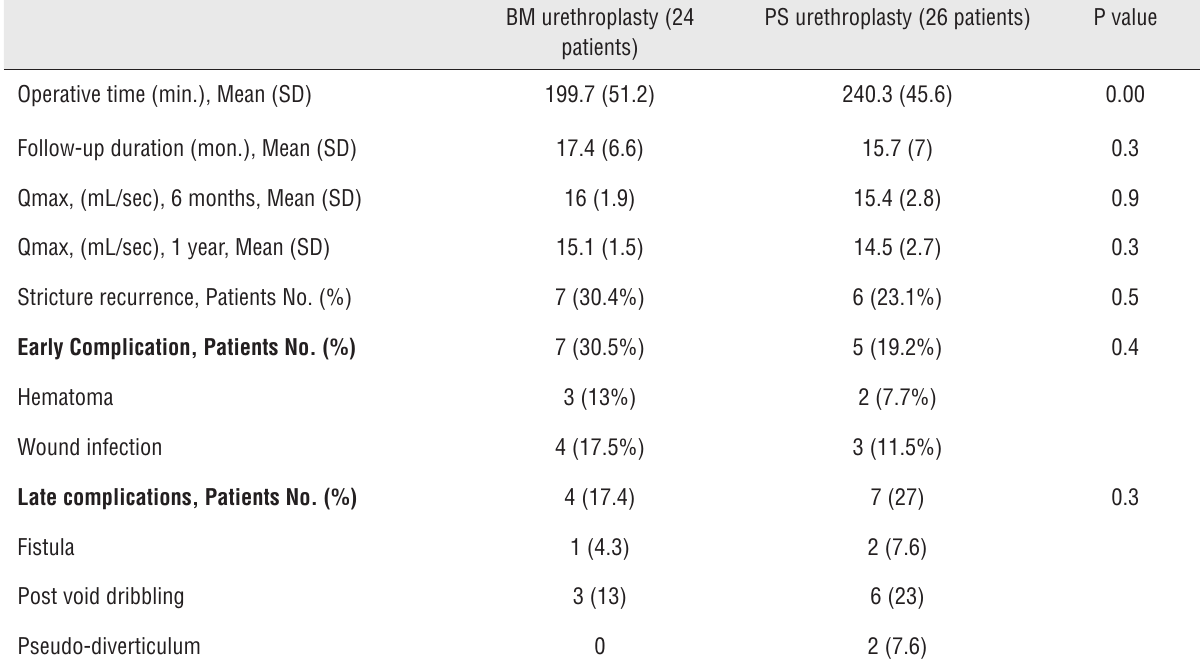
Table 2 - surgical outcome.